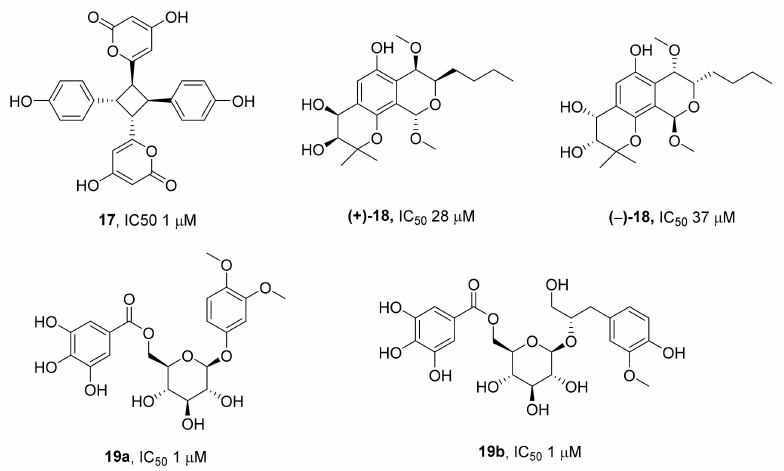
Figure 6. Natural polyphenols as TDP1